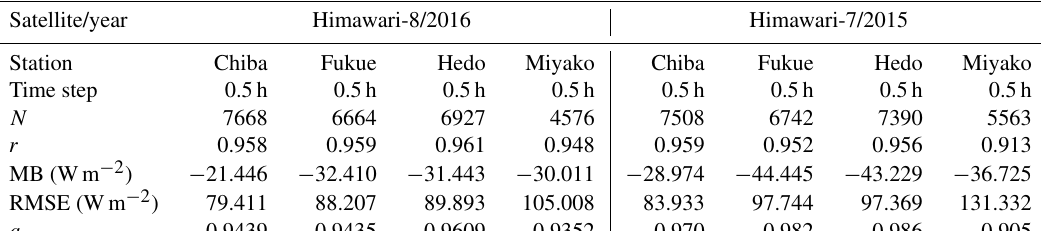
Table 1. Comparison of Himawari-8 and Himawari-7 data sets with surface SKYNET observations at the Chiba, Fukue, Cape Hedo, and Miyako stations in 2016 (see Fig. 2) and 2015, respectively. Results of the statistical analysis (N is the number of samples, r correlation coefficient, MB is mean bias, RMSE is root mean square error, a is the slope of the regression line) are reported for a 0.5h time step.